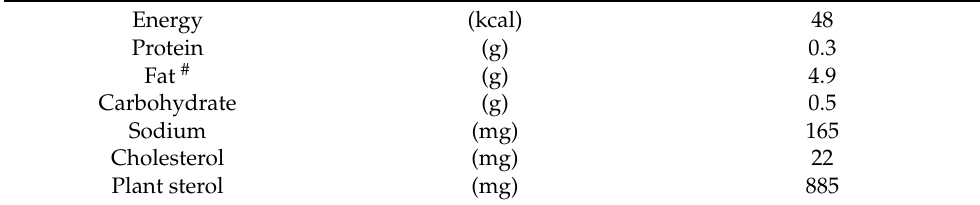
Table 1. Analytical composition of phytosterol-containing mayonnaise-type dressing *. Energy (kcal) 48 Protein (g) Fat